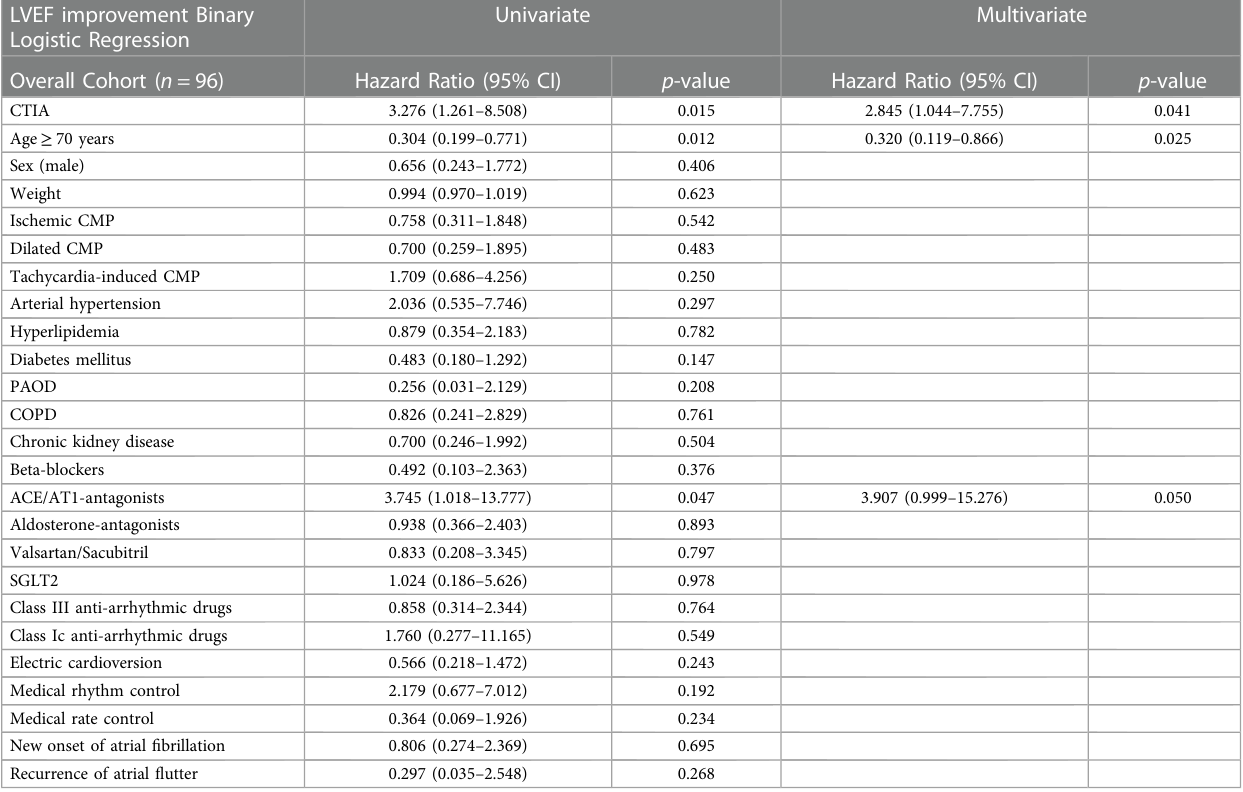
TABLE 3 Tabular overview of univariate and multivariate binary logistic regression of overall cohort with regard to various clinical characteristics and LVEF improvement. LVEF improvement Binary Logistic Regression